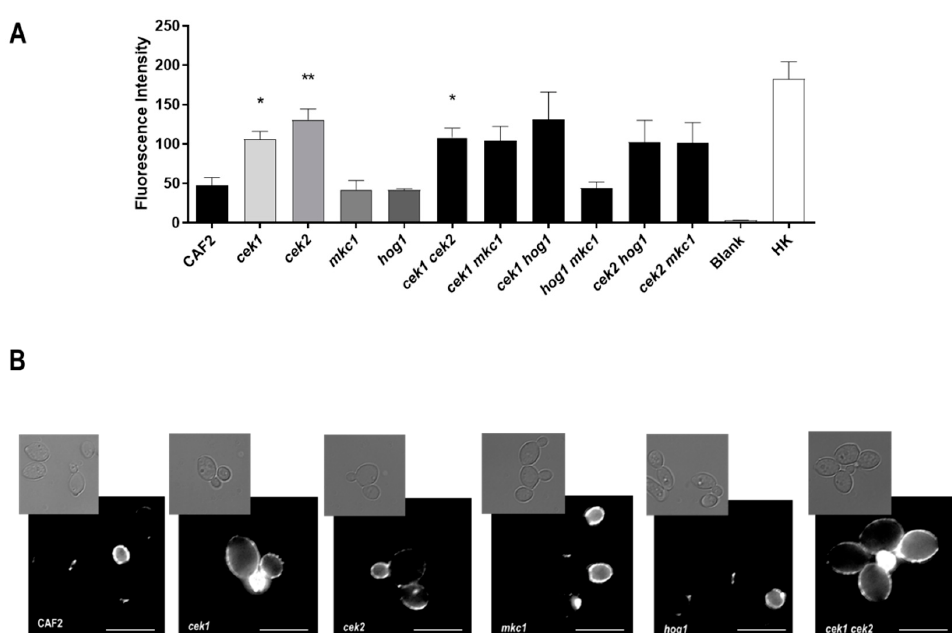
Figure 5. Analysis of β -glucan exposure in MAPK mutants. ( A ) Mean values of the fluorescence intensity for each strain (arbitrary units) and the standard error of the mean (SEM) from three independent experiments are shown. Heat-killed cells (HK), used as positive control Blank refers to cells treated only with the secondary antibody. * p < 0.05, ** p < 0.01 ( B ) Fluorescence microscopy analysis of cells β glucan exposure. Representative pictures of fluorescence microscopy analysis Pictures were taken and processed likewise for brightness and contrast adjustments. Upper panels, brightfield; lower panels, immunofluorescence microscopy. The white bar represents 5 μ m.